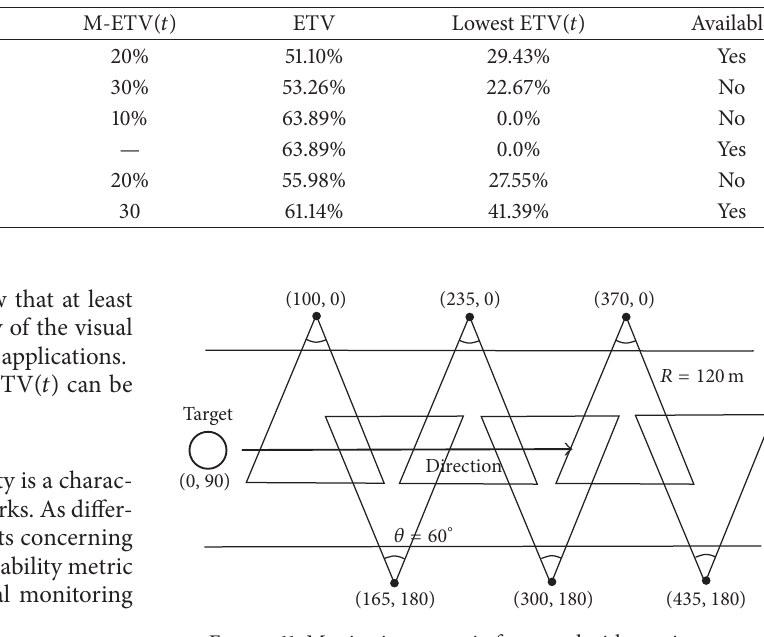
tion, considering targets that move through an area covered by fixed visual sensors. That scenario emulates visual moni- toring over a road for moving cars, which may have different dimensions. Initially, that scenario is composed of six visual sensors deployed in two imaginary parallel lines, with three cameras positioned in each of these lines, as presented in Figure 11. For the performed verifications, all visual sensors have 𝑅 = 120 m and 𝜃 = 60 ∘